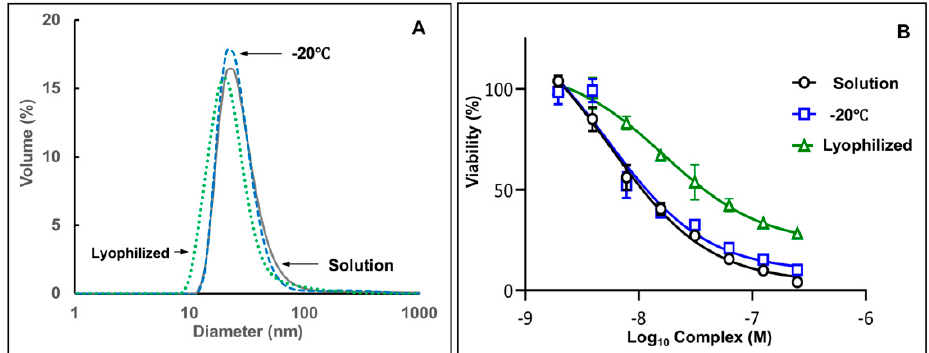
Figure 6. ( A ) DLS profiles and ( B ) dose-potency relationship in cell-based viability assay for quisino- stat-PPEG complexes in solution, after freeze/thaw cycle ( − 20 °C) and lyophilization (complex com- position: 51:1 quisinostat-to-PPEG; solution in 25 mM phosphate buffer; viability experiments: WM115 Melanoma Cells; n = 3; points represent the mean values with errors indicating standard deviation).